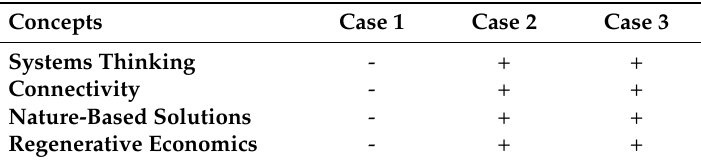
Table 3. Concepts in the three exemplary